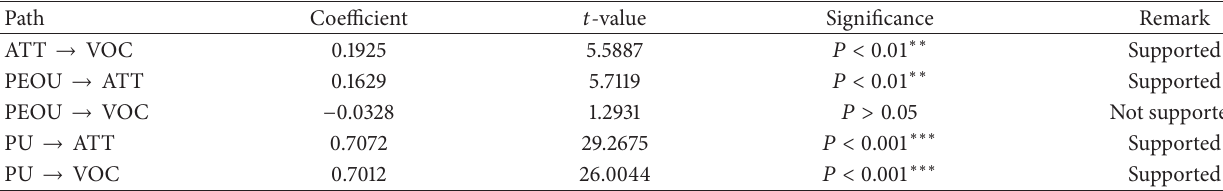
Table 5: Summary of hypotheses